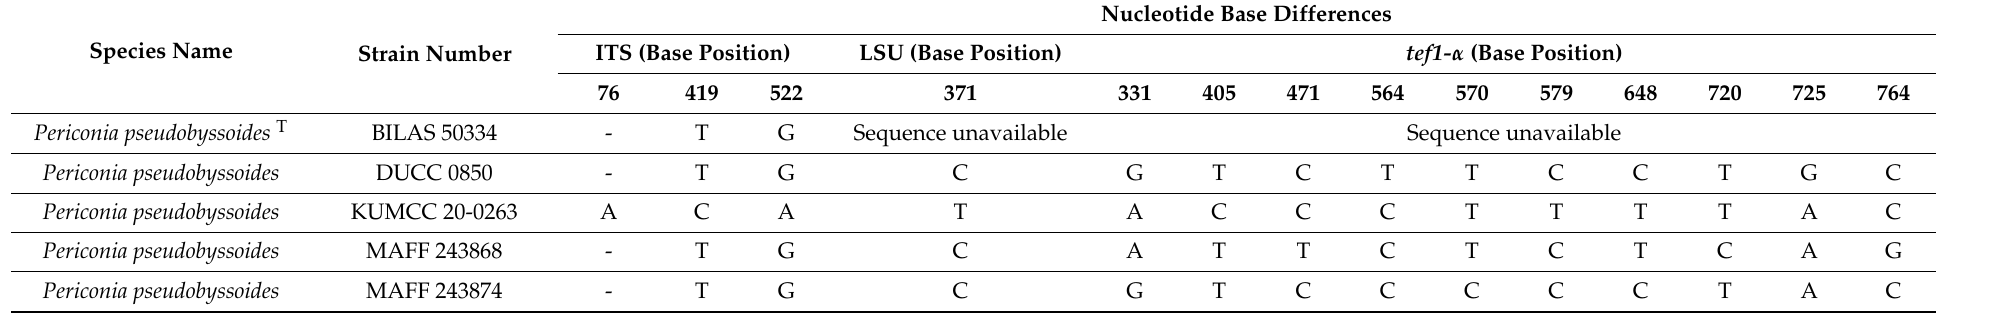
Table 5. Polymorphic nucleotides from the ITS, LSU, and tef1- α sequence data of Periconia pseudobyssoides . The newly generated strain is indicated in bold black and the type strain is indicated as superscript